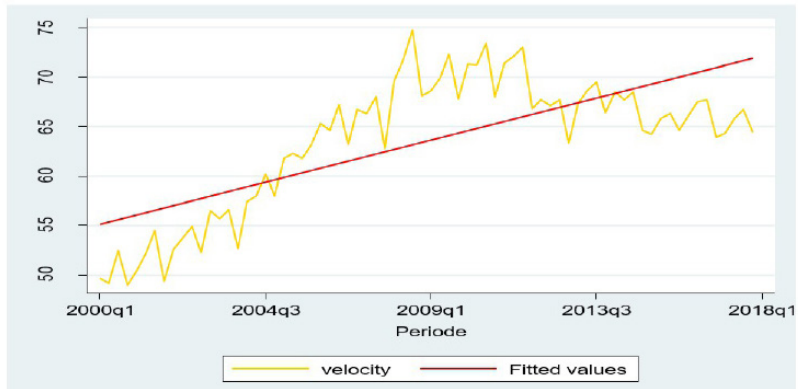
Figure 4: Velocity of Broad Money in Indonesia Period